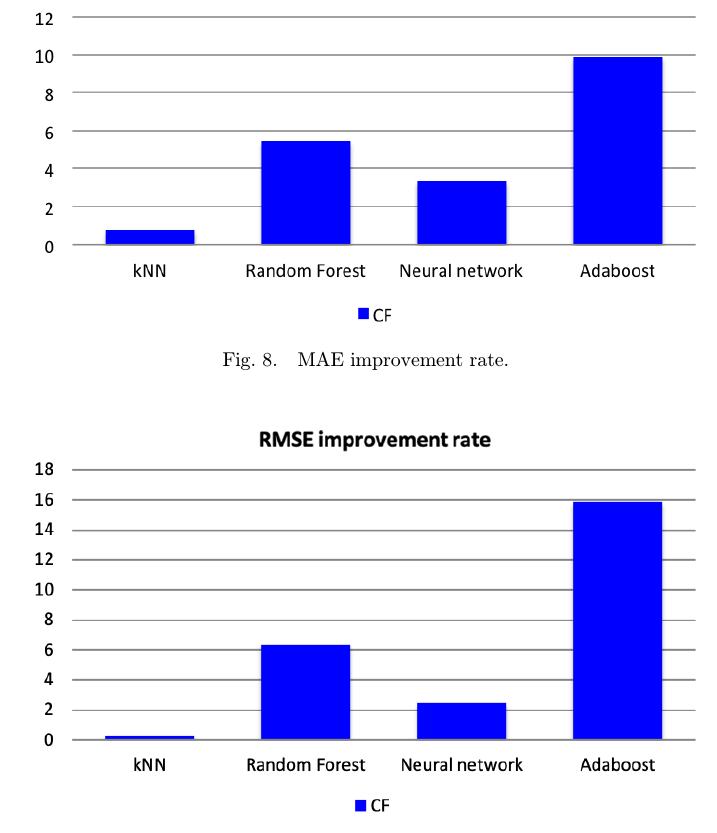
Fig. 9. RMSE improvement